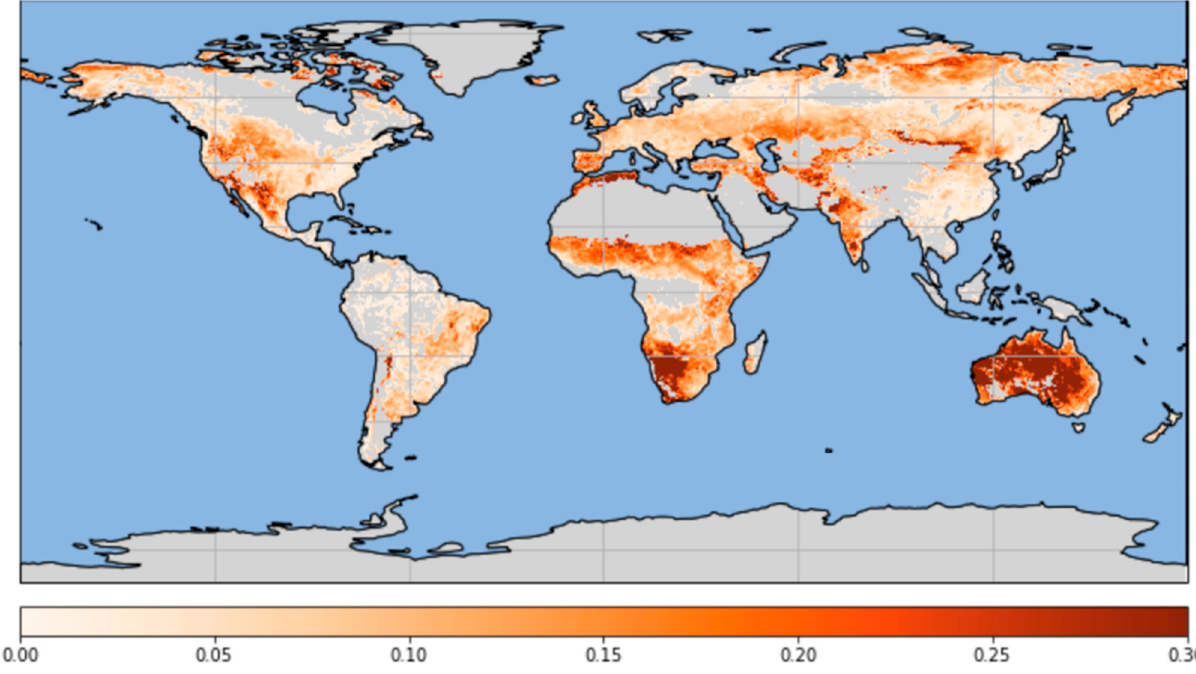
Figure 2. Climatologic b/y [-] (see Section 2). We use all 8-day data of microwave VOD and optical LAI from 2003 to 2019 to perform the linear regression. Pixels which show a statistically significant slope between microwave VOD and optical LAI (student’s t -test, p < 0.05) are depicted.